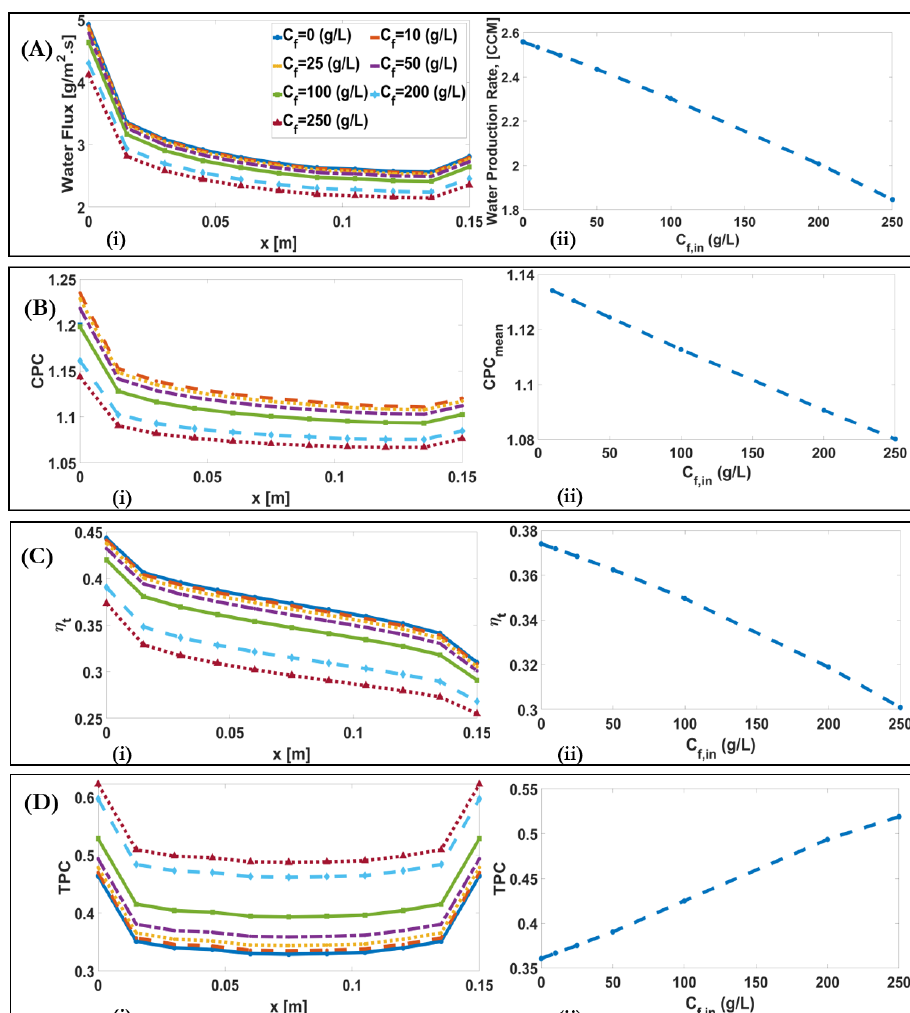
Figure 10. ( A ) ( i ) Downstream alterations of water flux for different inlet feed concentrations of a DCMD system; ( A ) ( ii ) Alteration of water production rate with varying inlet feed concentrations of a DCMD system. ( B ) ( i ) Downstream alterations of CPC for different inlet feed concentrations of a DCMD system; ( B ) ( ii ) Alteration of maximum CPC with varying inlet feed concentrations of a DCMD system. ( C ) ( i ) Downstream alteration of 𝜂 𝑡 for different inlet feed concentrations of a DCMD system; ( C ) ( ii ) Alteration of mean 𝜂 𝑡 with varying inlet feed concentrations of a DCMD system. ( D ) ( i ) Downstream alteration of TPC for different inlet feed concentrations of a DCMD system. ( D ) ( ii ) Alteration of mean value of TPC with varying inlet feed concentration.